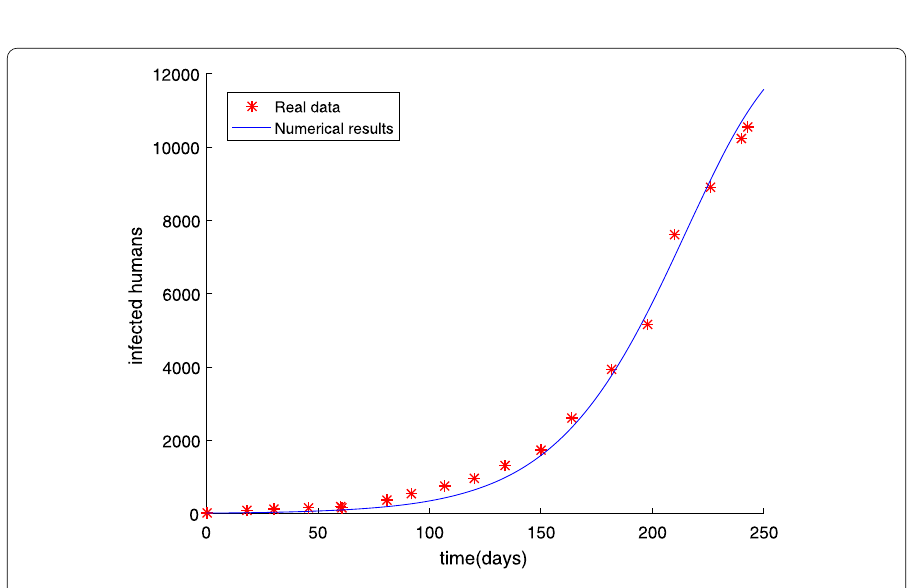
Figure 5 The number of Ebola infections I ( t ) in Guinea, Liberia, and Sierra Leone compared with the numerical results of fractional order system (53) obtained by the MGAM method and g ( U ∗ ) = 0.2744